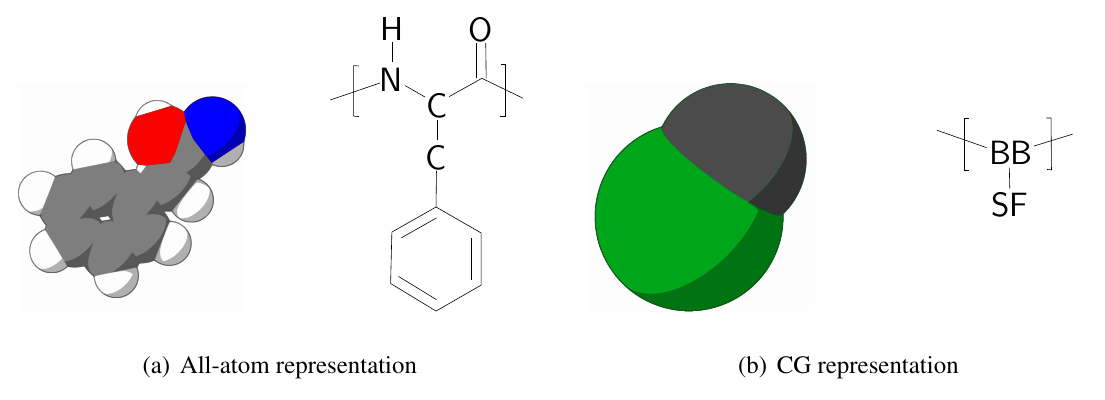
Figure 1. Mapping of the all-atom representation of phenylalanine (figures to the left, both schematic and as chemical composition) to its CG representation (figures to the right). The center of the CG backbone particle is determined by the position of the C the CG sidechain particle is positioned along the C the repetitive unit.